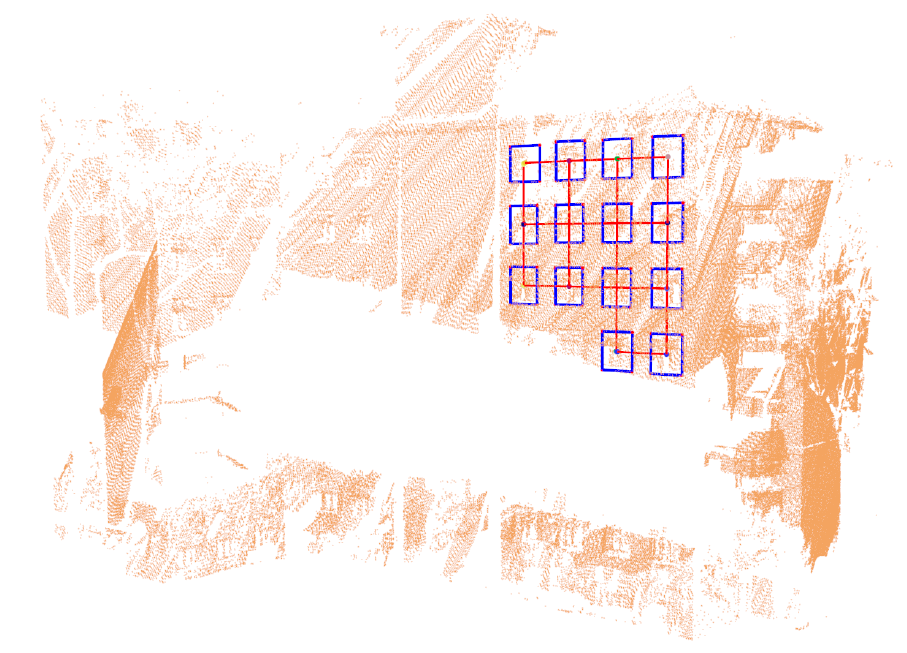
Figure 8. Facade opening and layout reconstruction on mobile LiDAR point cloud data. Blue frames represent detected openings with the association represented in red